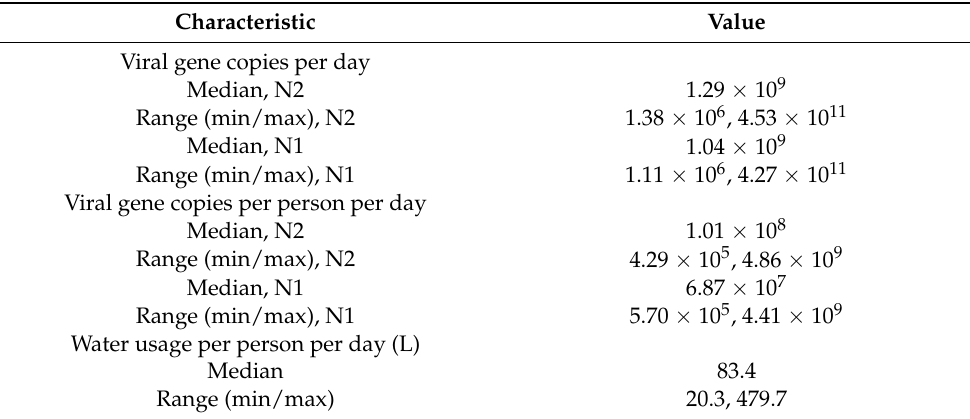
Table 1. Quantification of viral loads and viral loads per person in the isolation